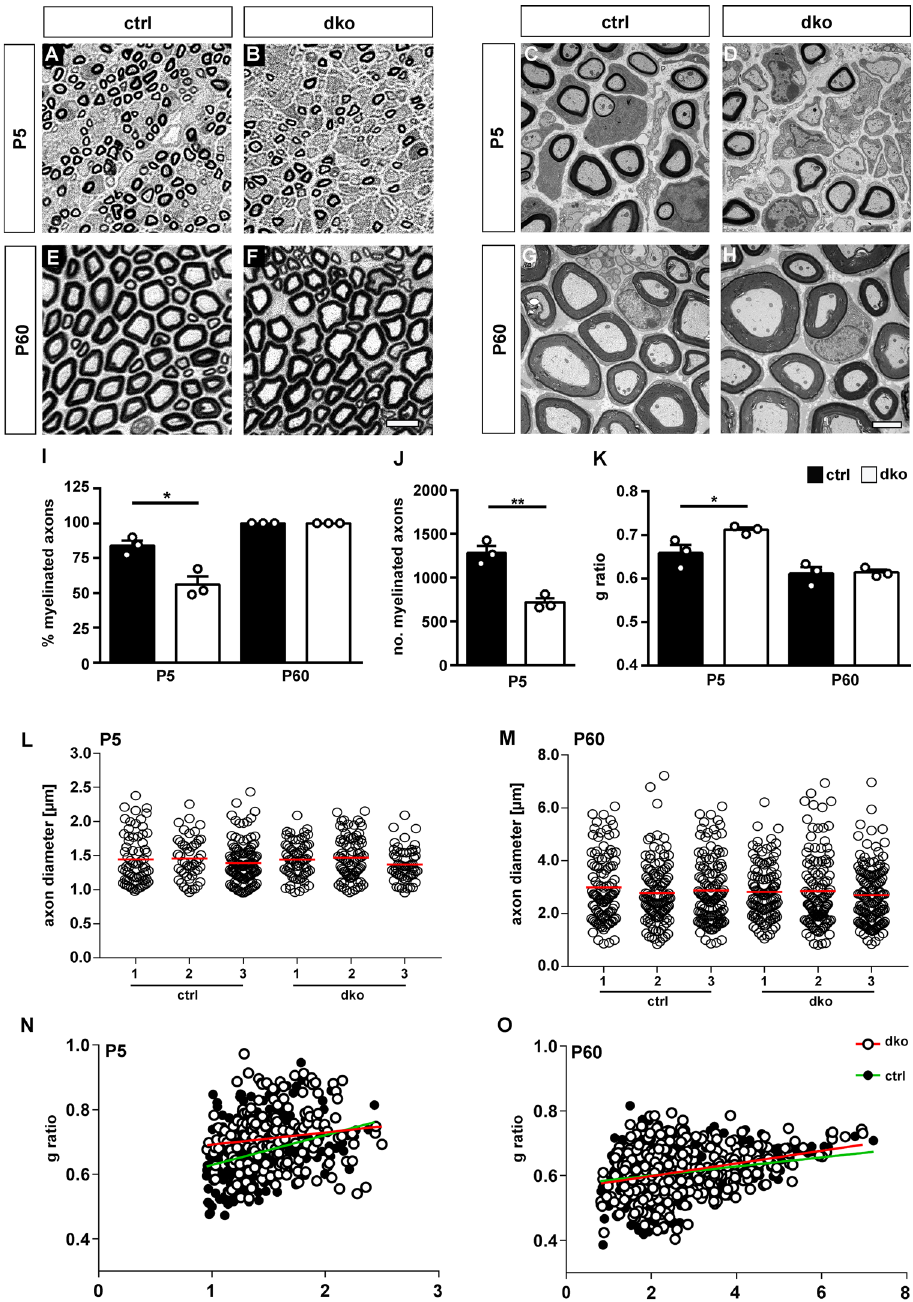
Figure 7. Histology and ultrastructure of sciatic nerves of dko mice. ( A–H ) Representative PPD stainings ( A,B,E,F ) and electron microscopic pictures ( C,D,G,H ) of sections of sciatic nerve tissue of control and dko mice at P5 and P60. Scale bars, 10 µm (left) and 2 µm (right). ( I ) Percentage of myelinated axons in sections of sciatic nerves from control and dko mice at P5 and P60 (n = 3; ± SEM). ( J ) Absolute number of myelinated axons per section in sciatic nerves from control (black bars) and dko (white bars) mice at P5 (n = 3; ± SEM). ( K ) Determination of average g ratios of myelinated axons in sections of sciatic nerves from control and dko mice at P5 and P60 (n = 3; ± SEM). Statistical significance was determined by unpaired, two-tailed Student’s t-test (*P ≤ 0.05; **P ≤ 0.01). For p-, t- and df-values, see Supplementary Fig. S3. ( L,M ) Diameters of myelinated axons in sciatic nerves from three individual control and dko mice at P5 ( L ) and P60 ( M ). Red lines depict mean values. ( N,O ) Scatter blot showing single g ratios of 100–150 myelinated axons in sciatic nerves from control (black dots) and dko (white dots) mice at P5 ( N ) and P60 ( O ). Green and red lines show linear